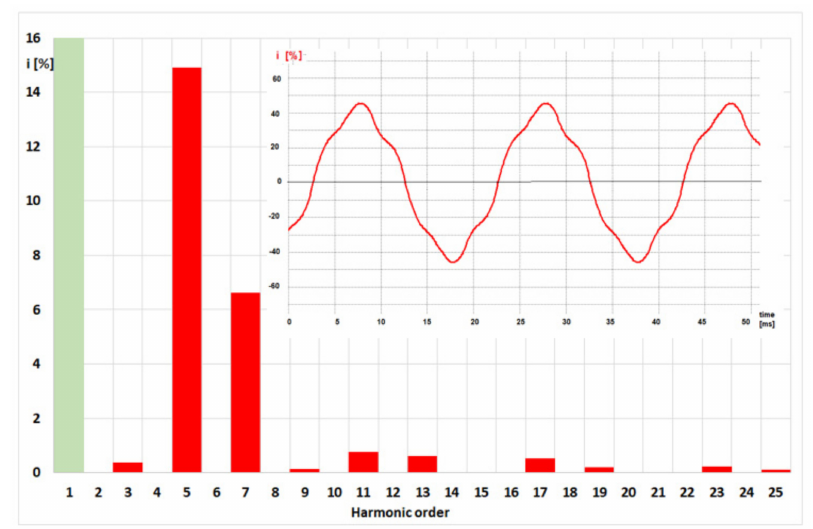
Figure 6. Spectrum of current harmonics and current waveform recorded at point A. Much higher current distortion takes place at the level of voltage U n = 30 kV. Spectrum of current harmonics and current waveform recorded at point A’ are shown in Figure